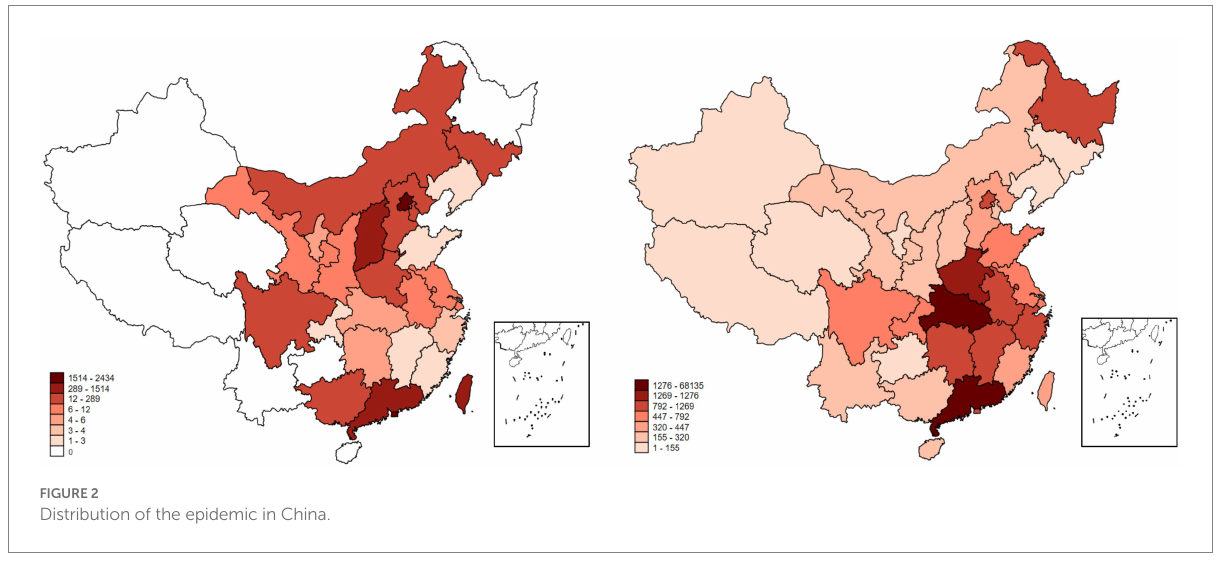
FIGURE 2 Distribution of the epidemic in China.